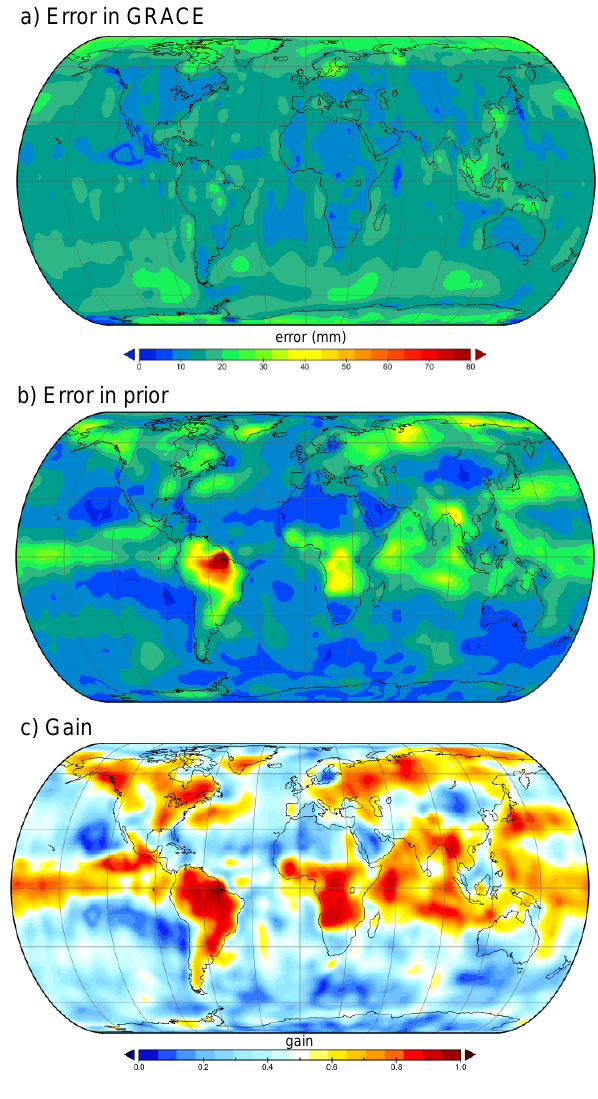
Figure 2. Triple collocation estimated error in storage change from the merged (a) GRACE and (b) prior estimates, and (c) resulting gain